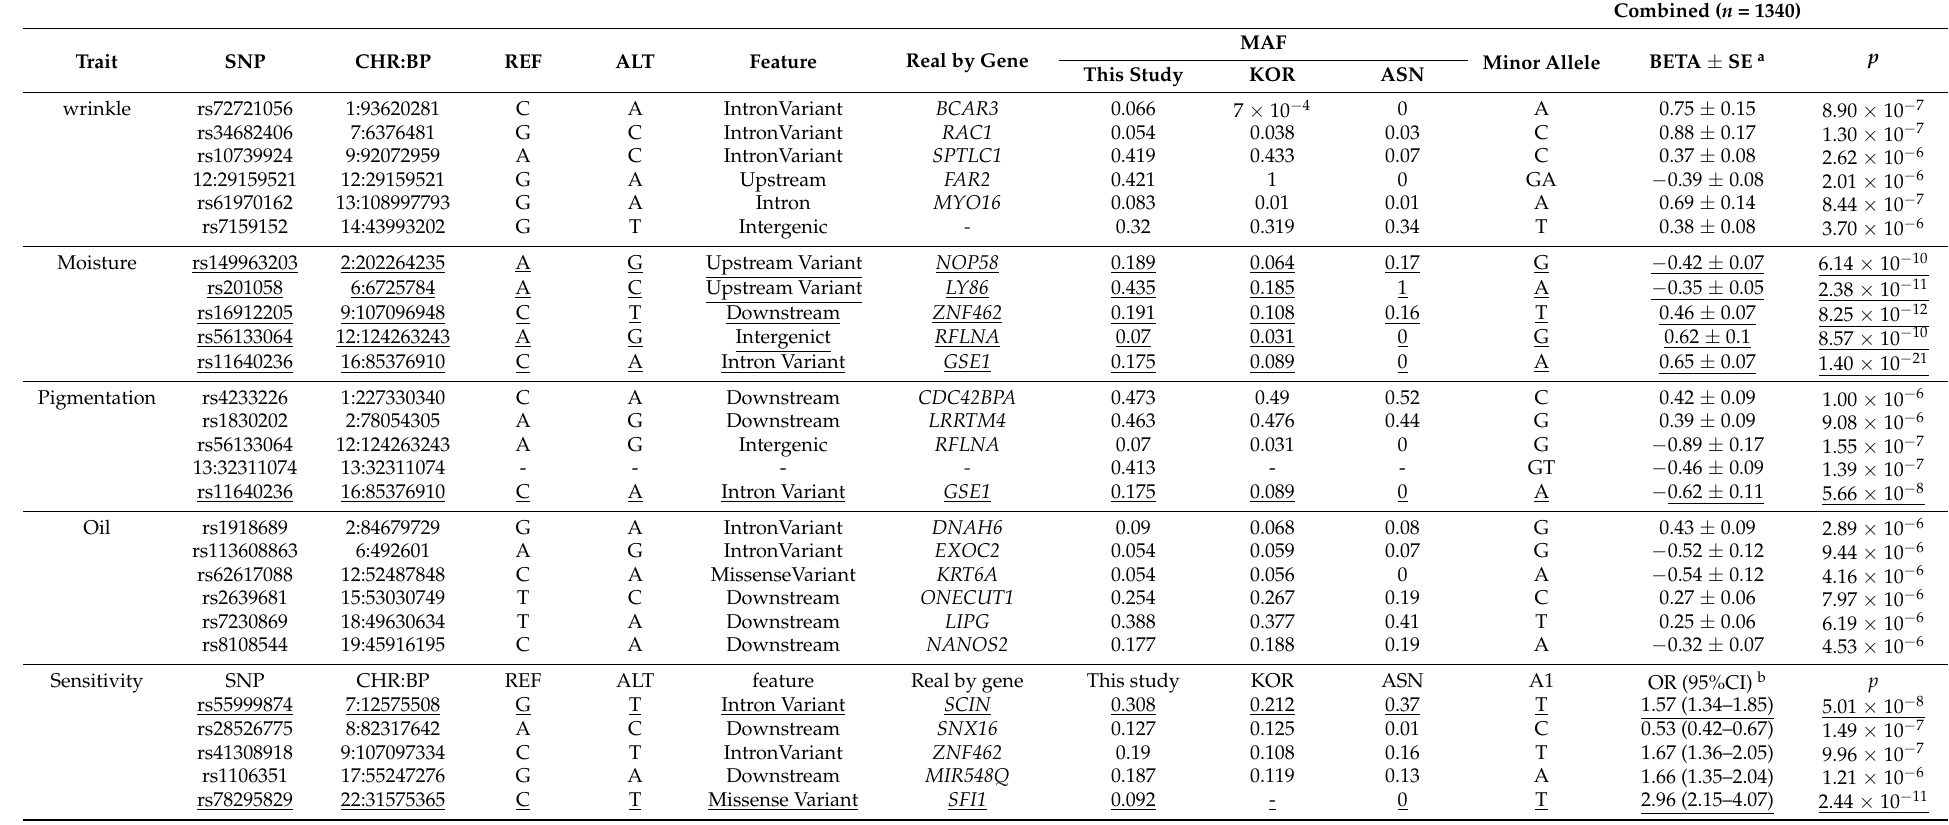
Table 2. Summary of significant new skin phenotype loci according to